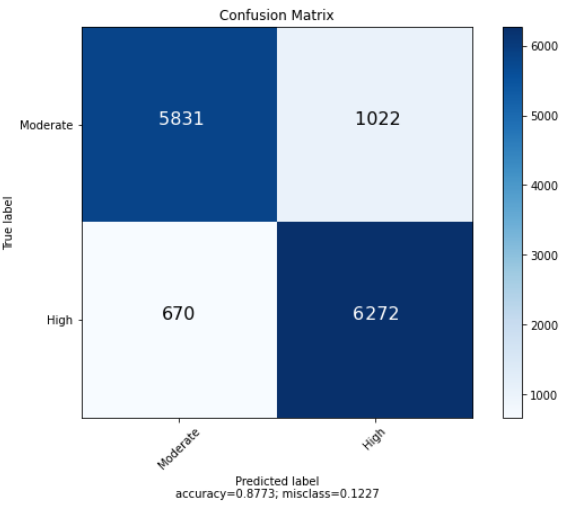
Figure 11. Confusion matrix for the test set (13,795 samples). The positive class corresponds to high